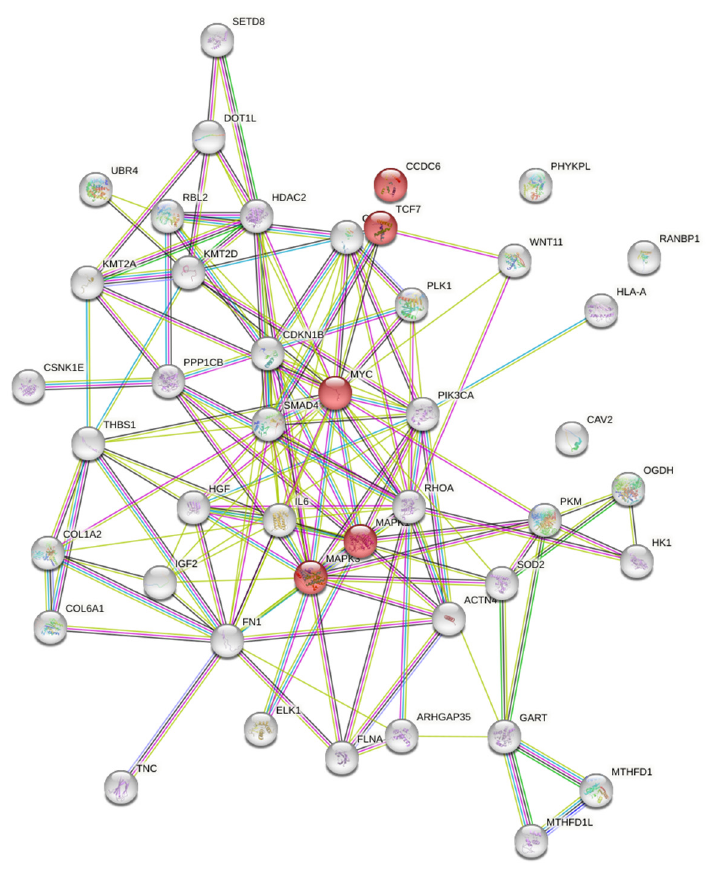
Figure 1. Protein-protein interactions between proteins associated with autophagy (https://string- db.org/; accessed on 27 January 2023). The edges colored purple reflect experimentally proven rela- tionships, blue—relationships, information about which is obtained from supervised databases. Green edges reflect the neighborhood in the genome, blue—the joint occurrence, red—the fusion of genes. Light green ribs mean a joint mention of these proteins in Pub-Med Abstracts, black—co- expression, and light blue—homology. Note: Interactions: